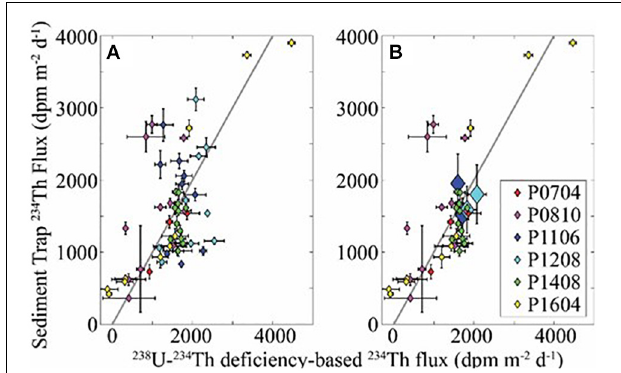
FIGURE 2 | (A) Comparison of sediment trap and 238 U- 234 Th-based measurements of 234 Th flux for all Lagrangian cycles for cruises P0704, P0810, P1408, and P1604. Black line is 1:1 line. Non-parametric Spearman’s ρ = 0.51 ( p = 4.9 × 10 – 5 ). (B) Same as (A) but uses cruise averages for P1106 and P1208. Non-parametric Spearman’s ρ = 0.60 ( p = 5.5 × 10 – 5